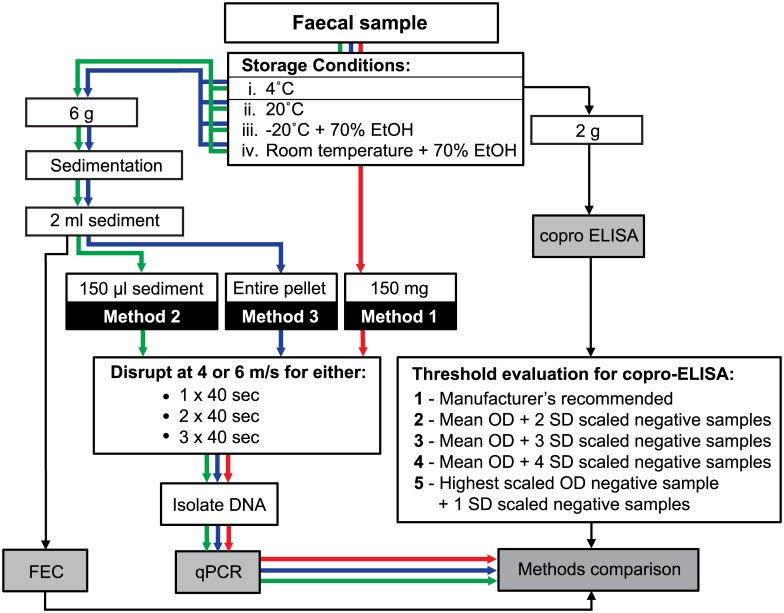
Comparison of three diagnostic methods for the diagnosis of fasciolosis in cattle faecal samples.A traditional sedimentation and faecal egg count (FEC) was performed and the results compared to a coproELISA and real-time PCR. Three methods of sample preparation were compared; isolation of DNA from 150 mg raw faeces (Method 1; red), sedimentation followed by isolation of DNA from 150 μl of the resultant sediment (Method 2; green), and sedimentation followed by isolation of DNA from the entire sediment pellet (Method 3; blue). Egg disruption prior to DNA isolation was assessed using six methods on a benchtop homogeniser using either 4.0 or 6.0 m/s for 1, 2 or 3 rounds of beating for 40 seconds between which samples were stored on ice. The manufacturer-recommended positive threshold of a commercially-available coproELISA was compared to four others suggested in the literature; mean scaled optical density (OD) of negative samples + 2 × standard deviations (SD) of scaled negative samples (Threshold 2) [13], mean scaled OD of negative samples + 3 × SD of scaled negative samples (Threshold 3) [13–15], mean scaled OD of negative samples + 4 × SD of scaled negative samples (Threshold 4) [13], and highest scaled OD of negative samples + 1 SD of negative samples (Threshold 5) [16].